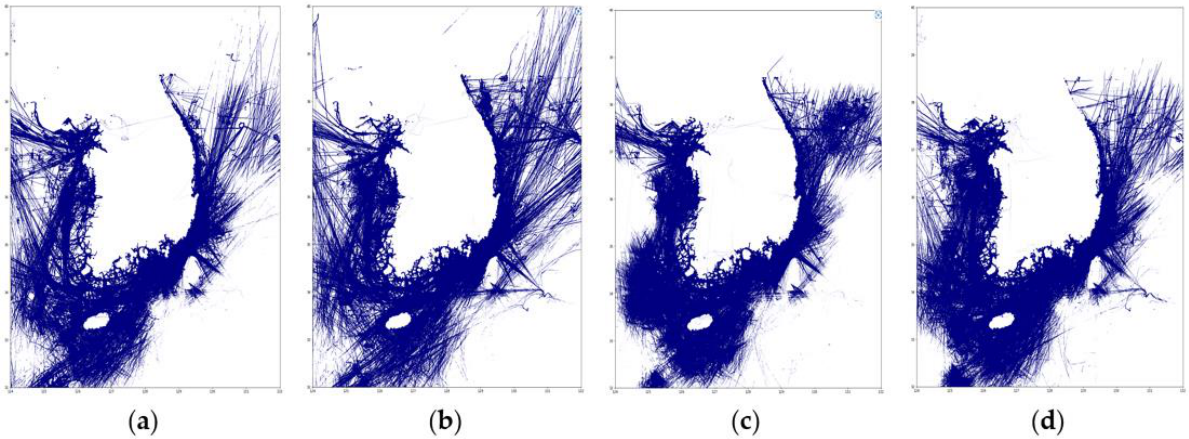
Figure 2. Maritime traffic status based on AIS raw data by season: ( a ) spring; ( b ) summer; ( c ) fall; and ( d ) winter. Table 2. Statistical analysis results using raw AIS data.